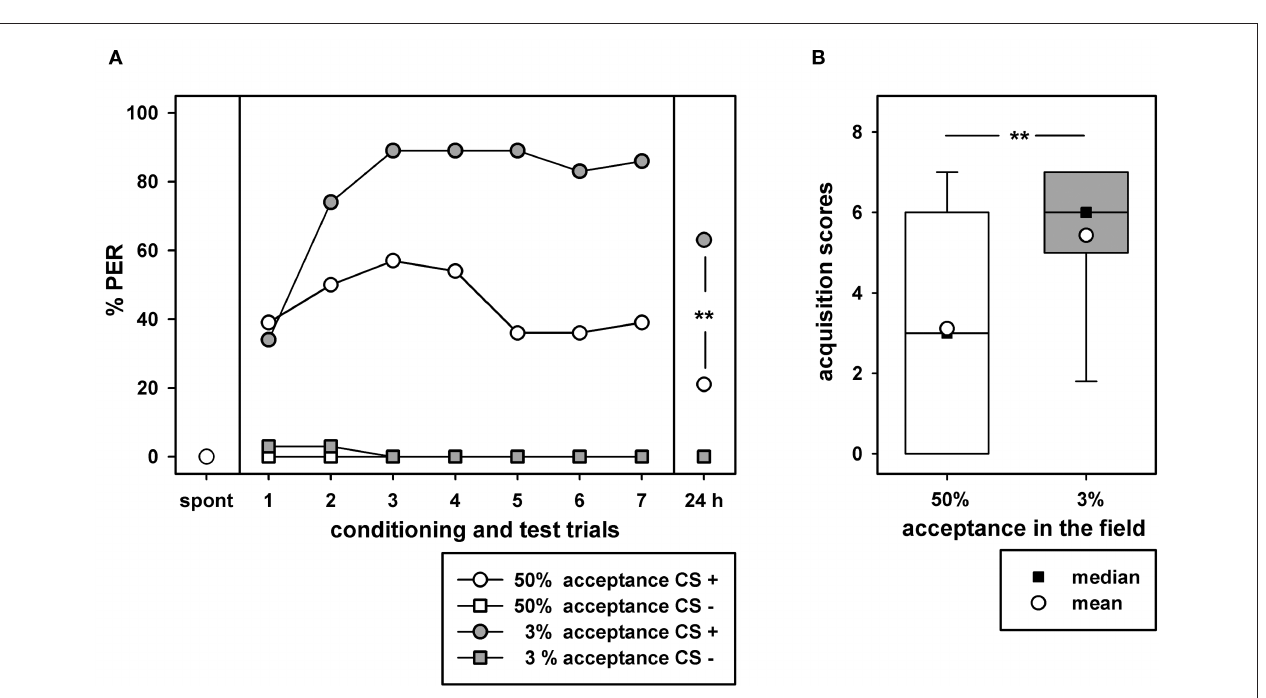
shows the percentages of PER for each stimulus. (B) The gustatory response scores for the two groups (for details see text). The box plots show medians, means, quartiles, the whiskers indicate 95% percentiles. 35 bees were tested in the 3% acceptance group and 28 bees in the 50% acceptance group.